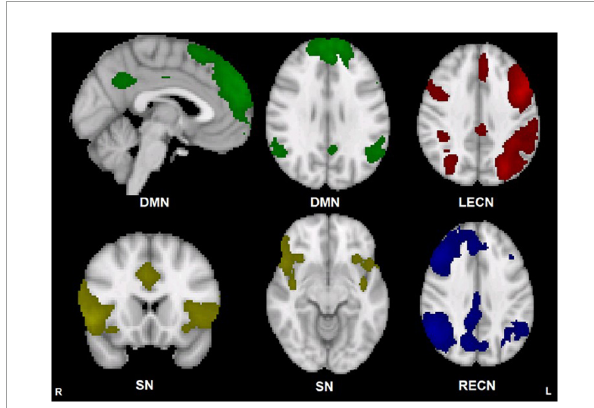
FIGURE1 Group template maps generated from FSL MELODIC ICA for all subjects thresholded arbitrarily at Z ≥ 3 for display purposes. Units are Z-scores calculated by dividing the original component connectivity strength at each voxel by the standard deviation of the residual noise. The left side of the brain is on the viewer’s right side for the axial and coronal images. Color depictions and MNI coordinates (mm) of the slice location of each image: DMN – green [sagittal slice: x = –2], [transverse slice: z = 29], SN – yellow [coronal slice: y = 18], [transverse slice: z = –10], LECN – red [transverse slice: z = 36], RECN – blue [transverse slice: z = 36].